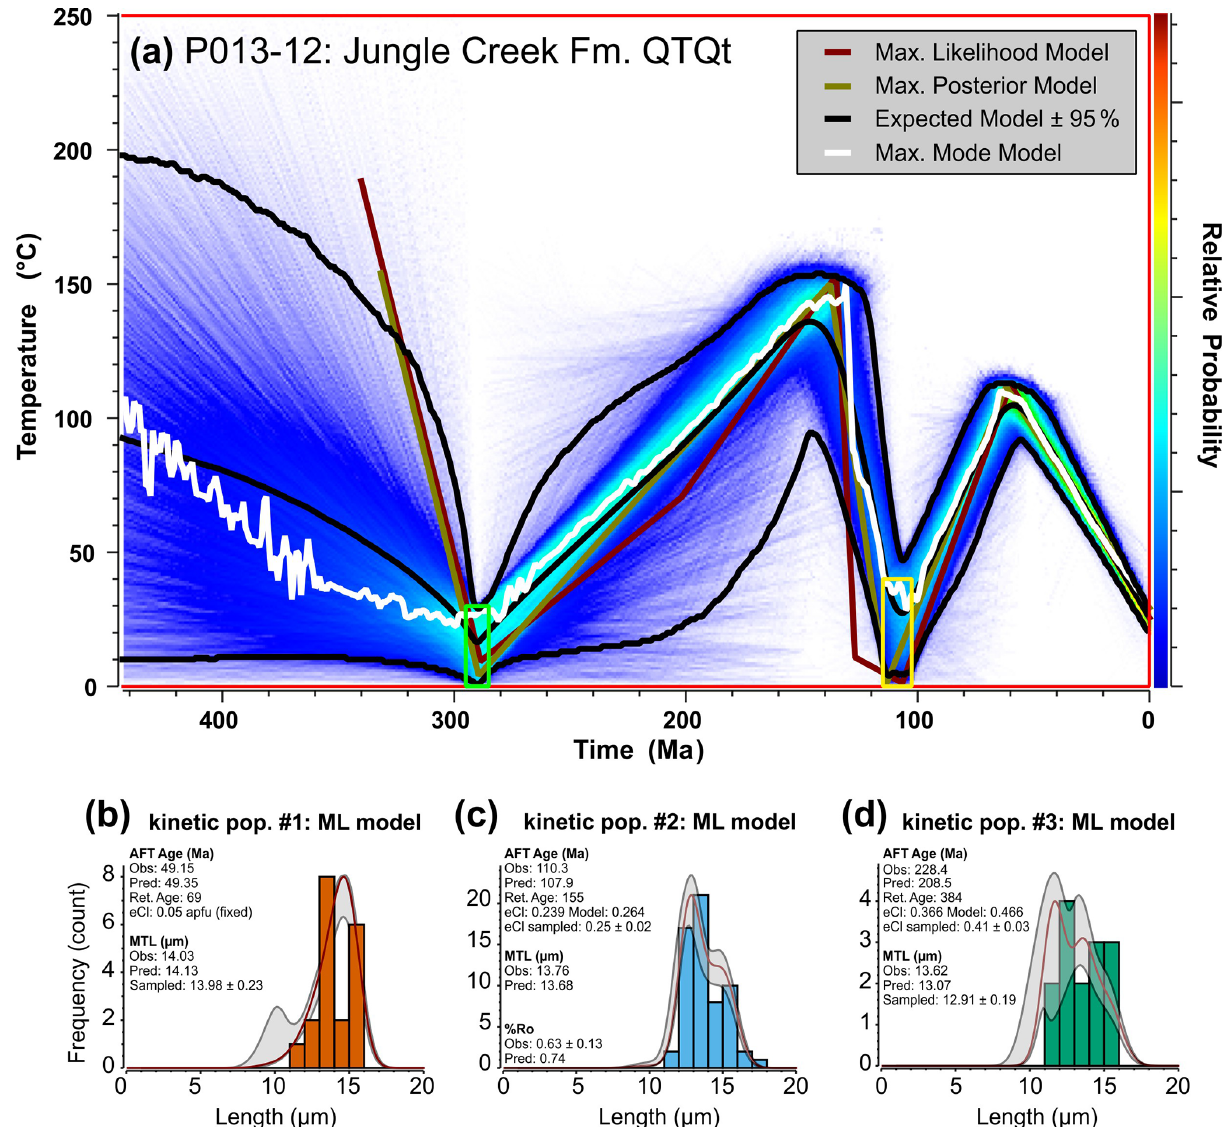
Figure 8. QTQt model results for Permian detrital AFT sample P013-12 (Jungle Creek Fm.). (a) Time–temperature plot of the histories retained post burn-in coloured according to relative probability, with warmer colours denoting higher probability. Individual models include the maximum likelihood (highest likelihood and best fit; red curve), maximum posterior (preferred Bayesian model with the simplest, balancing fit with complexity; gold curve), maximum mode (peak of the marginal distribution at 1Myr intervals; white curve), expected (weighted mean of the marginal distribution ± 95% credible interval; black curves). The latter two models are summaries of the posterior distribution and not directly sampled during the inversion. (b) Maximum likelihood fit to the track length distribution and predictions for AFT age and MTL for population one using a fixed eCl value of 0.05apfu. (c) Maximum likelihood fit to the track length distribution and predictions for AFT age and MTL for population two, allowing for resampling of the calculated eCl value. (d) Maximum likelihood fit to the track length distribution and predictions for AFT age and MTL for population three, allowing for resampling of the calculated eCl value. The green box is the depositional age of 290 ± 5Ma (15 ± 15 ◦ C). The yellow box is the geologic constraint at 108 . 75 ± 6 . 25Ma (20 ± 20 ◦ C). Note that all populations utilize the central AFT age in QTQt, whereas the pooled age is used in AFTINV for samples with < 10% age dispersion. The model setup is as follows: 500000 iterations (burn-in) and 500000 iterations (post burn-in; shown). The prior model space is 300 ± 300Ma and 125 ± 125 ◦ C. The modern surface temperature is 25 ± 10 ◦ C, and the maximum allowed ∂T/∂t is 20 ◦ CMyr − 1 . Proposal moves were rejected if proposed outside of the prior, and more complex models were rejected for equivalent likelihood. See Sect. 4.2 for further